Question: Which visualization type does this figure use?
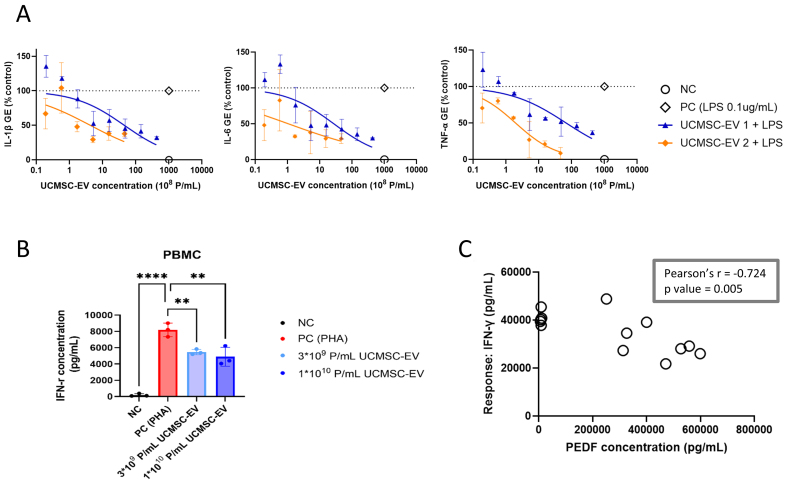
Answer: bar